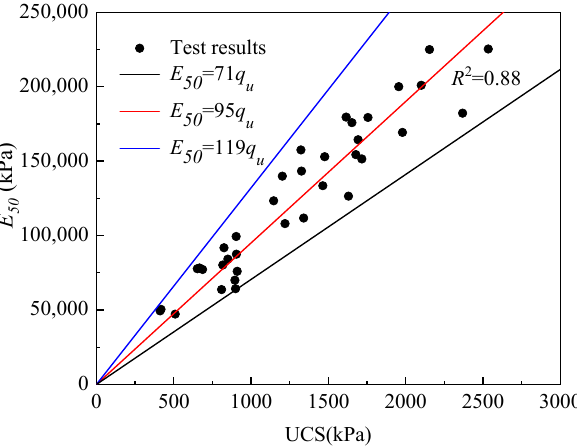
Figure 9. Correlation between the deformation modulus and UCS of the cemented soil.